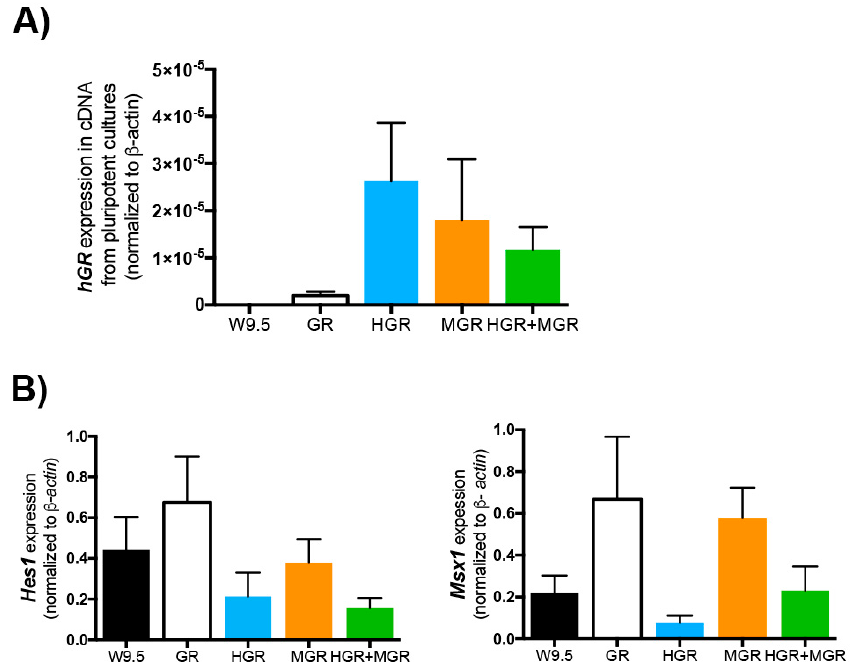
Figure 5. RT-PCR to detect the transgenic human glucocorticoid receptor and the endogenous Hes1 and Msx1 in pluripotent wild-type and transgenic lines. RNA was obtained from W9.5, GR, HGR, MGR, and HGR+MGR cells growing in 2i/LIF. Retrotranscription was made to prepare cDNA, which was amplified by qPCR ( A ) with the primers listed in Methods. Wild-type W9.5 mESCs did not express